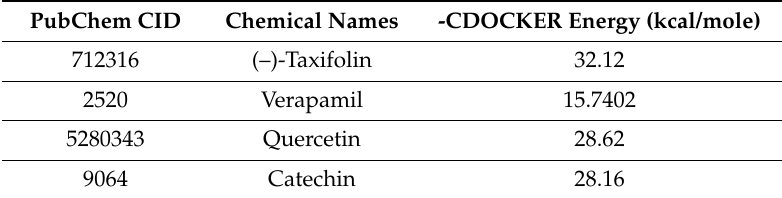
Figure 5. Molecular docking model P-glycoprotein antagonists. Superimposition of docked poses of compounds in the P-glycoprotein binding pocket of the X-ray structure (PDB id: 5KPI). ( A ) ( Left ) Bind pocket of P-gp; ( Right ) Docking pose of ( − )-taxifolin in the active site of P-gp ligand binding domain. ( B ) Docking pose of verapamil in the active site of P-gp ligand binding domain. ( C ) Superposition of the docked pose of ( − )-taxifolin (yellow atoms in dark green) and the X-ray pose of the agonist verapamil (green capped stick) in the active site of P-gp ligand binding domain. Hydrogen-bonding interactions are indicated by dashed ellipsoids.